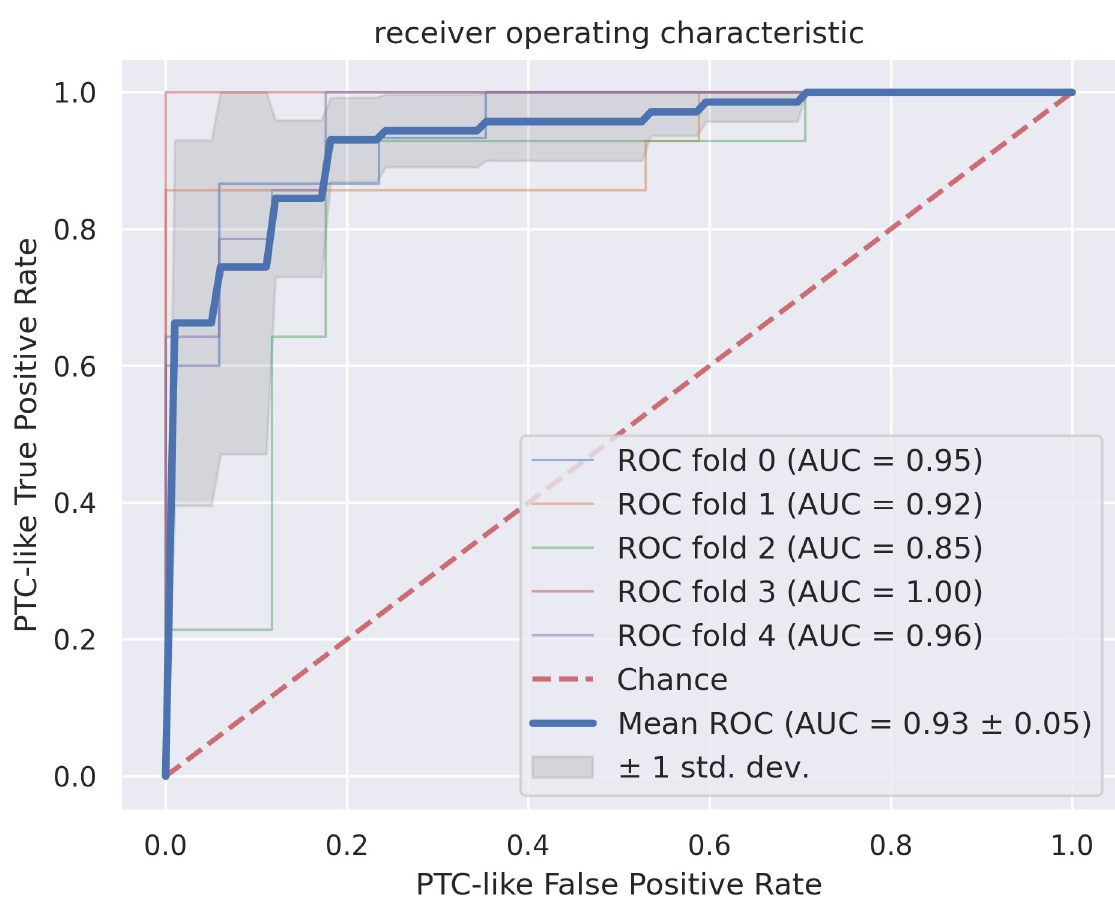
Fig 6. The receiver operating characteristic curves for the feature-based classification, where a true positive sample is a PTC-like sample classified as PTC-like. All cross-validation splits and the resulting area under curve (AUC) together with the resulting mean for the dataset are shown. The standard deviation around the mean is annotated in dark gray. The red dotted line corresponds to the classification by chance.